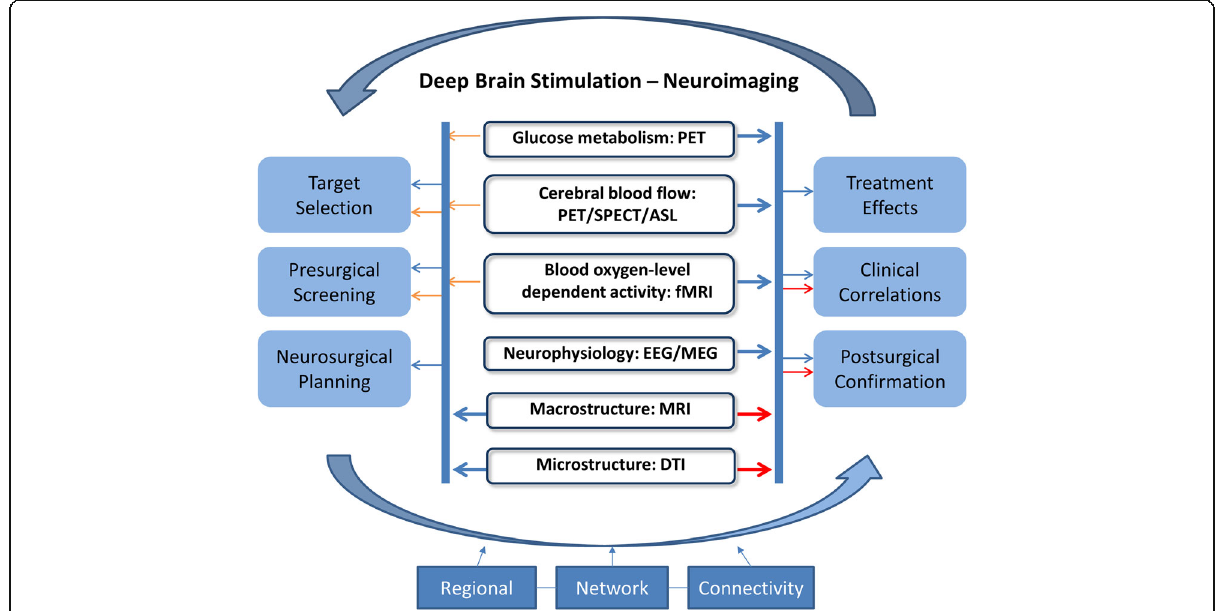
Fig. 1 A schematic to illustrate the synergistic interactions between neurosurgical interventions of brain stimulation and multimodal neuroimaging methods of functional and anatomical markers. It also showcases the big feed-back loop and unique organic relationships among different domains that together drive the innovation in the implementation of this therapy in the context of clinical trial design and translational research. The major roles played specifically by individual techniques are represented using the same colors with greater contributions denoted by thicker lines